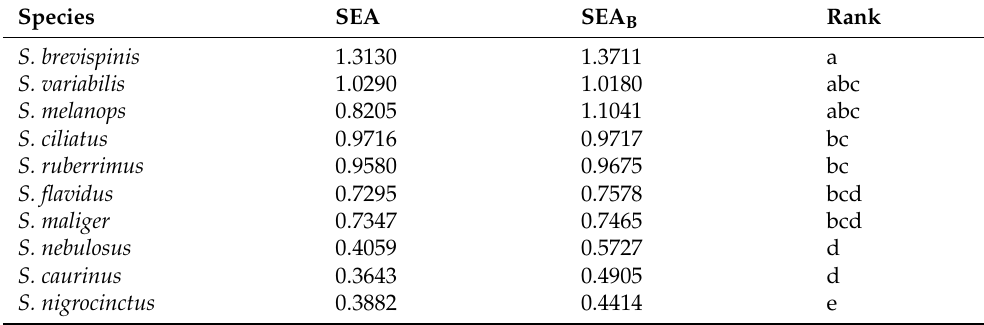
Table 2. Standard ellipse area (SEA) and Bayesian standard ellipse area (SEA B ) expressed in ‰ 2 and ranked by size, including ties, for ten rockfish species from southeast Alaska, USA.